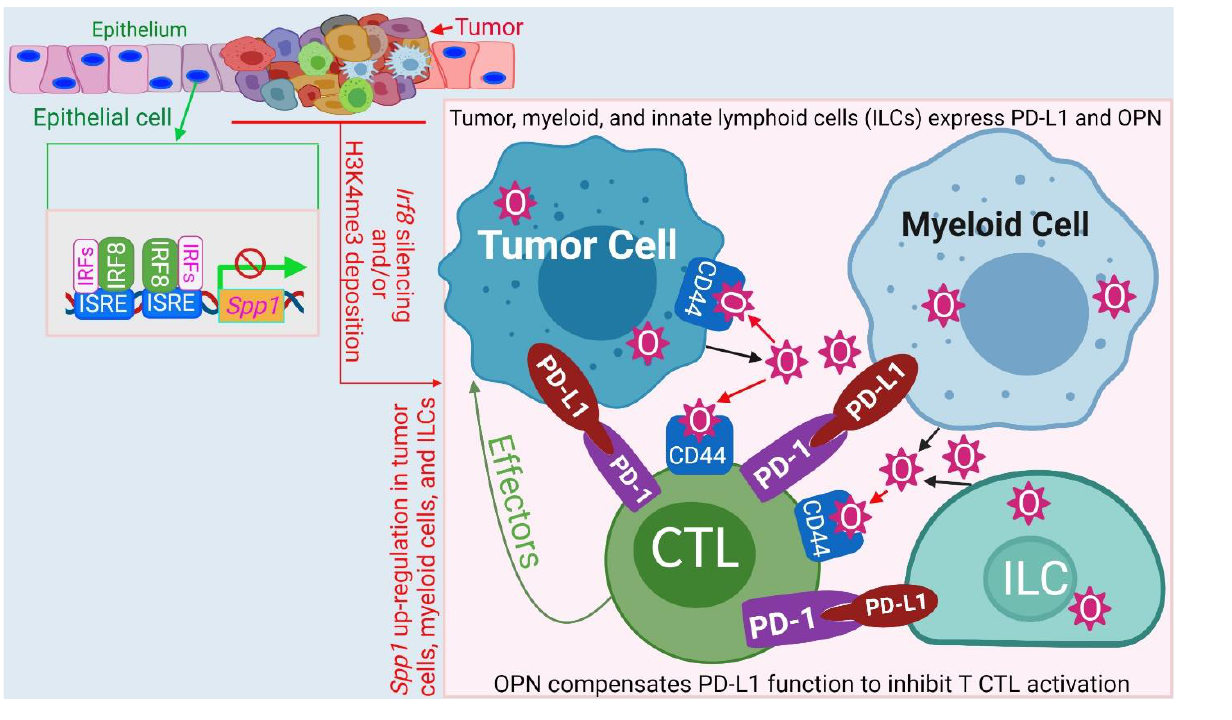
Figure 5. Model of the IRF8-OPN axis mechanism of action in immune suppression and tumor promotion. IRF8 functions as a repressor that binds to the two ISRE sites at the Spp1 promoter to repress Spp1 transcription in colon epithelial cells. During tumor development, Irf8 is silenced by its promoter DNA methylation and H3K9me3 deposition, resulting in increased OPN expression in tumor cells, MDSCs, and ILCs. OPN binds to CD44 to suppress T cell activation and to CD44 on tumor cells to promote tumor cell stemness and progression. The IRF8-OPN axis thus control tumor growth and progression through its functions in both the immune and non-immune cell compo- nents.